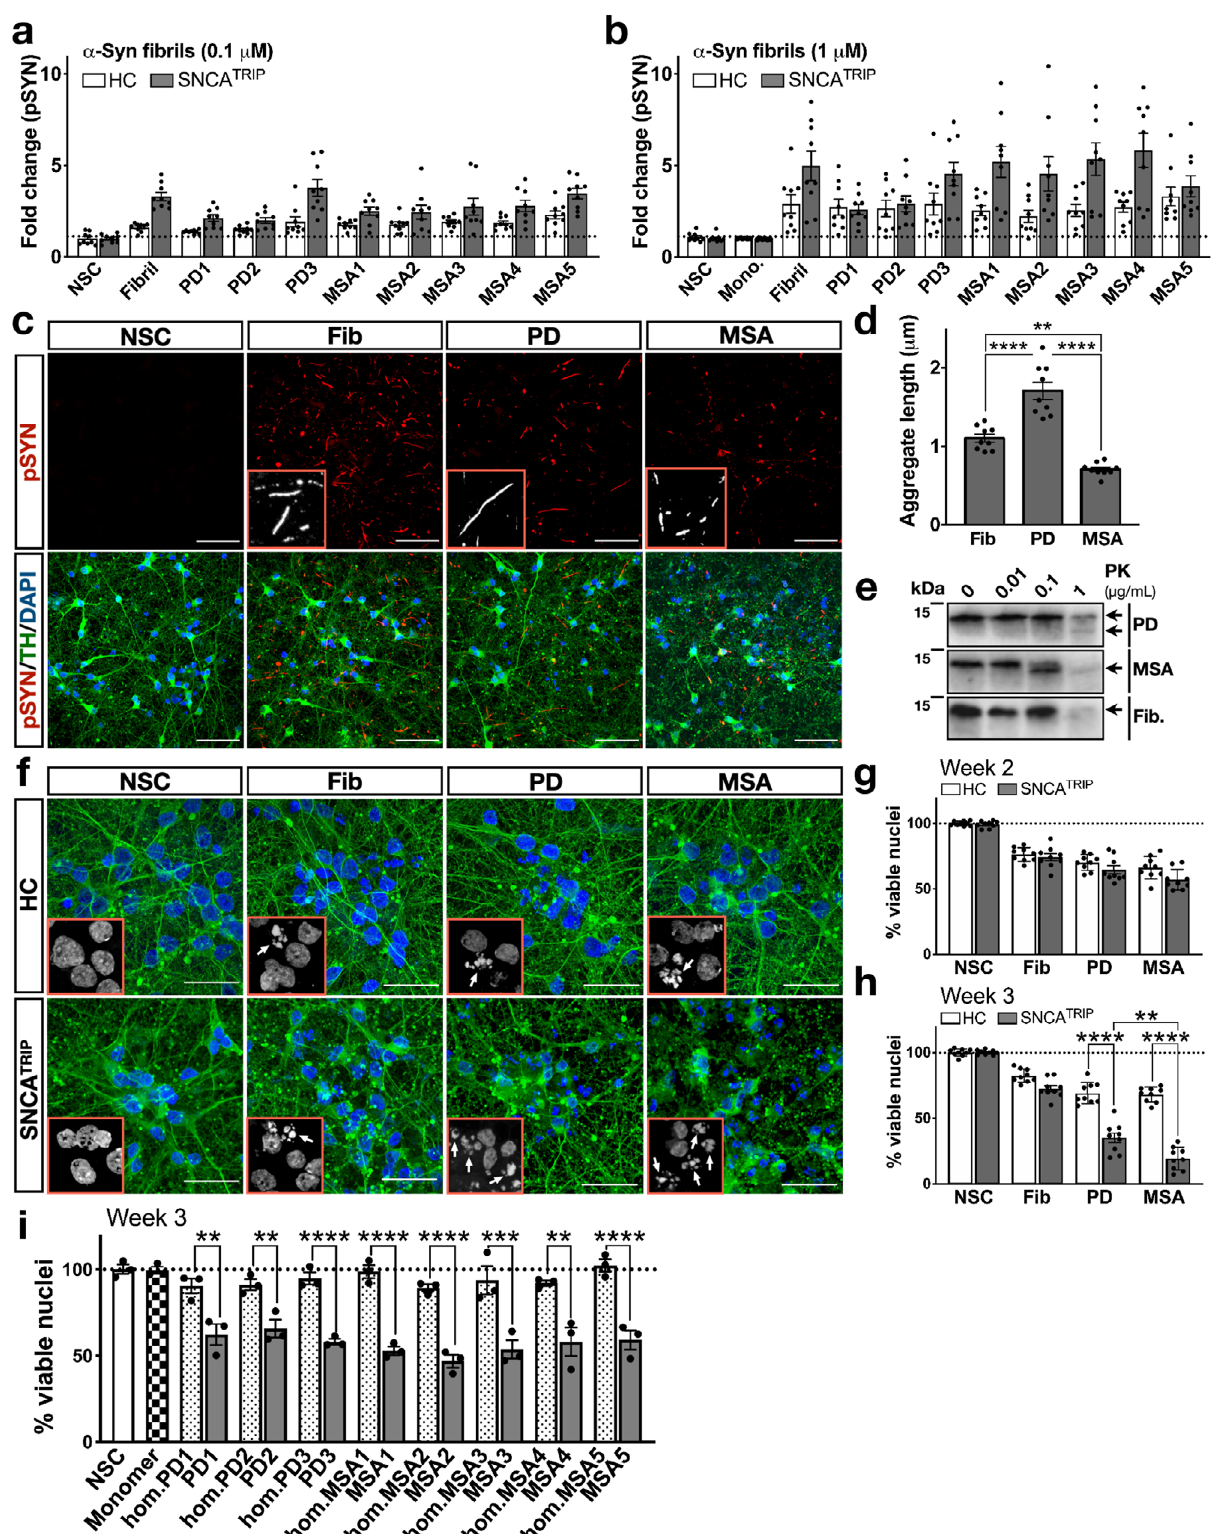
fi brils, pooled PD-ampli fi ed or pooled MSA-ampli fi ed fi brils. We chose week 1 post seeding because it was the earliest timepoint we observed consistent signal by FRET signifying endogenous α - synuclein aggregation (Fig. 1e), and week 2 post seeding because aggregation was more prominent while the neuronal loss was